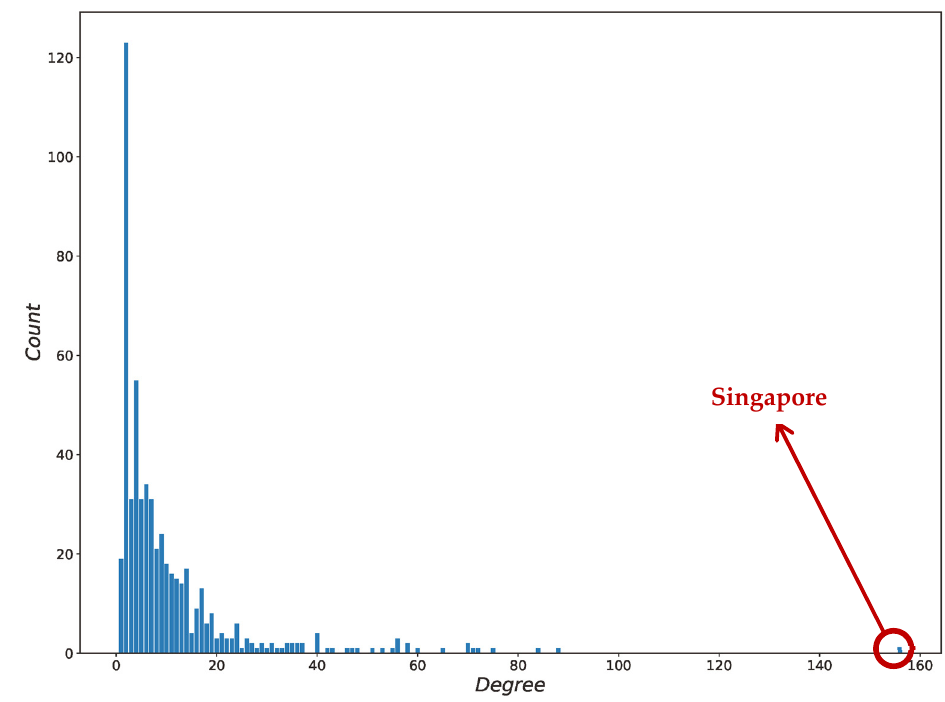
Figure 3. Degree distribution of GLSN.